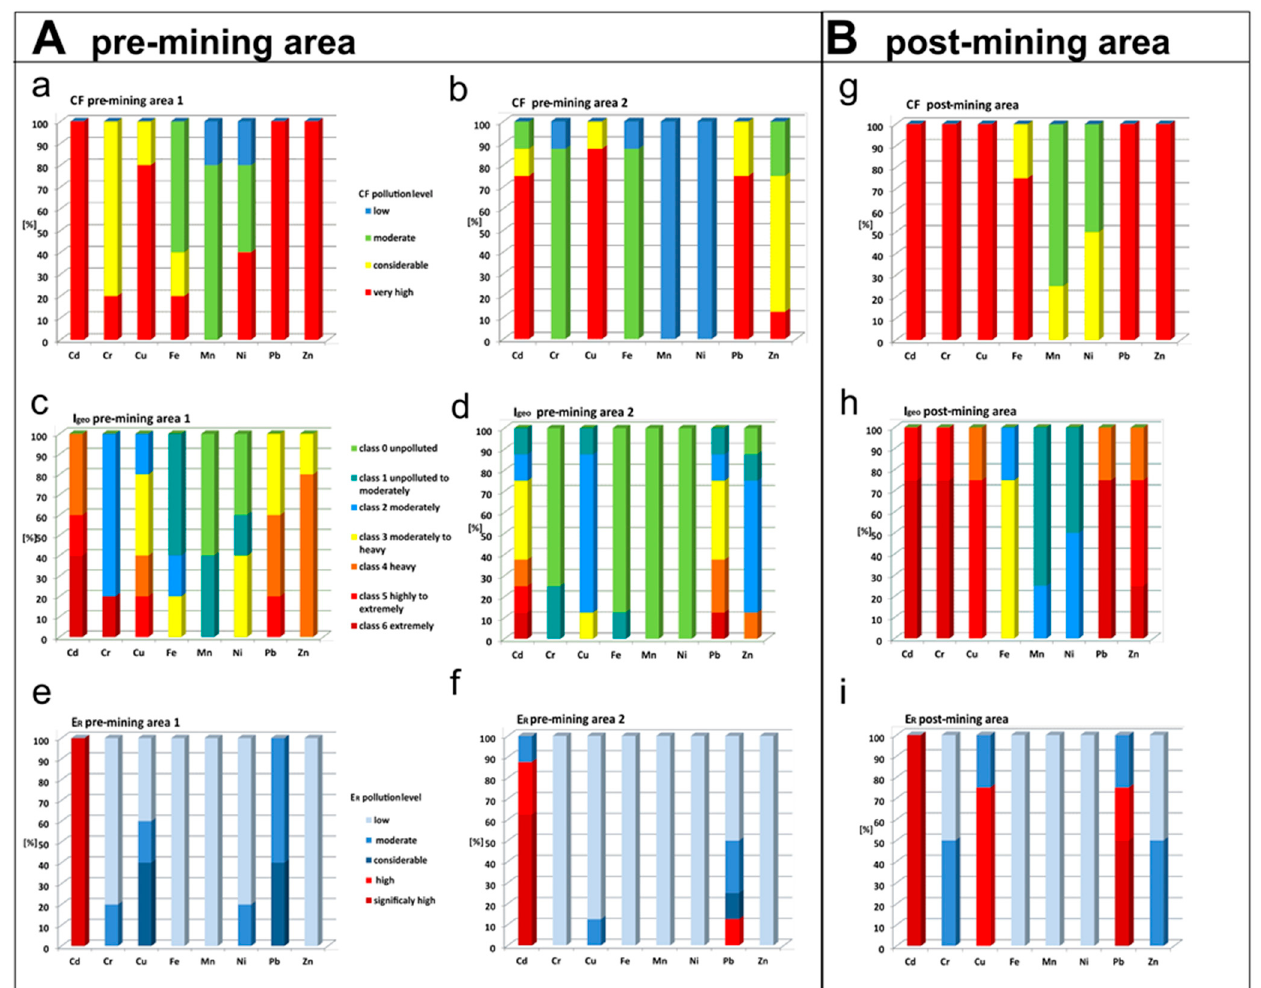
Figure 2. Distribution of CF ( a , b , g ), Igeo ( c , d , h ), and ER ( e , f , i ) in soil samples from ( A ): pre-mining areas and ( B ): post-mining area.